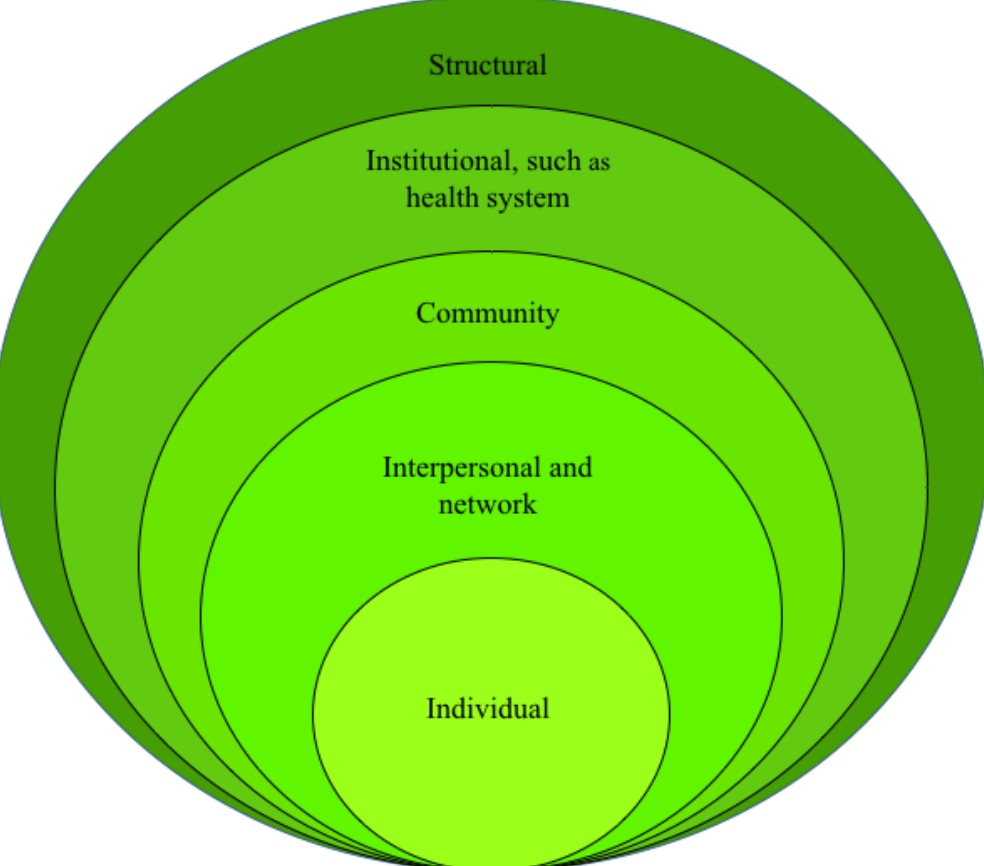
Figure 1. Effect of multiple integrated component interventions on the social ecological